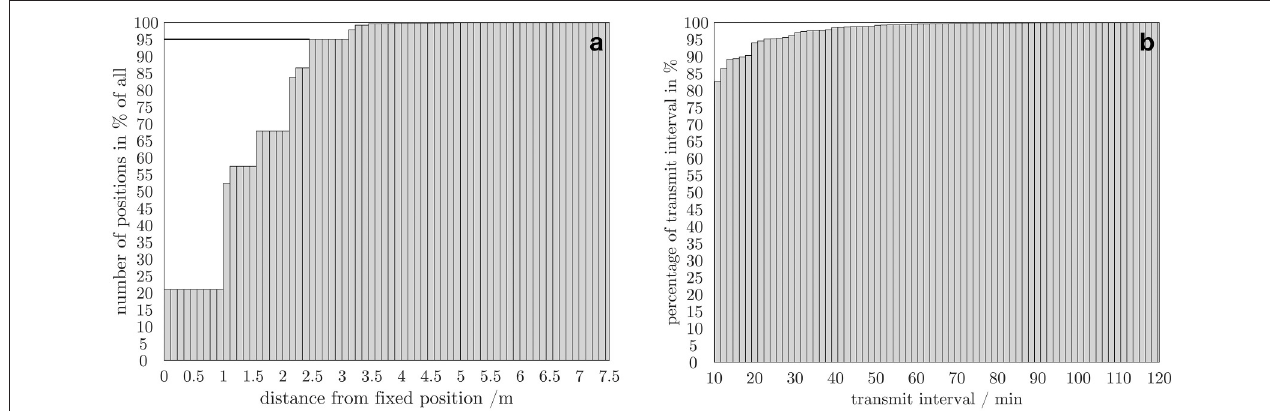
FIGURE 3 | Position accuracy (a) and transmission interval (b) shown in a cumulative histogram. For the position accuracy test the number of positions in percent of all positions are plotted against the distance from the fixed position (b) . The dashed line shows the 95th percentile and indicates that 95% of the positions have an error < 2.5m. The cumulative histogram for the transmission accuracy test shows the percentage of the transmission interval of all transmissions from all drifters as a function of the transmission